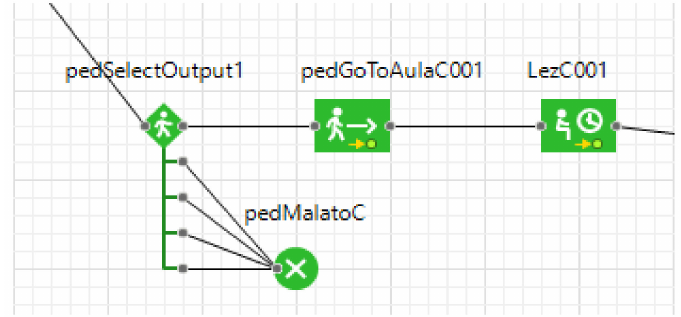
Figure 7. Healthy and infected rules.